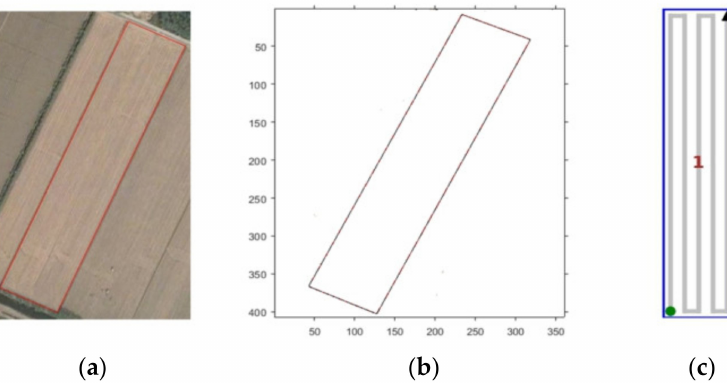
Figure 7. ( a ) The farmland map; ( b ) The map after binarization; ( c ) CCPP for simple regions.